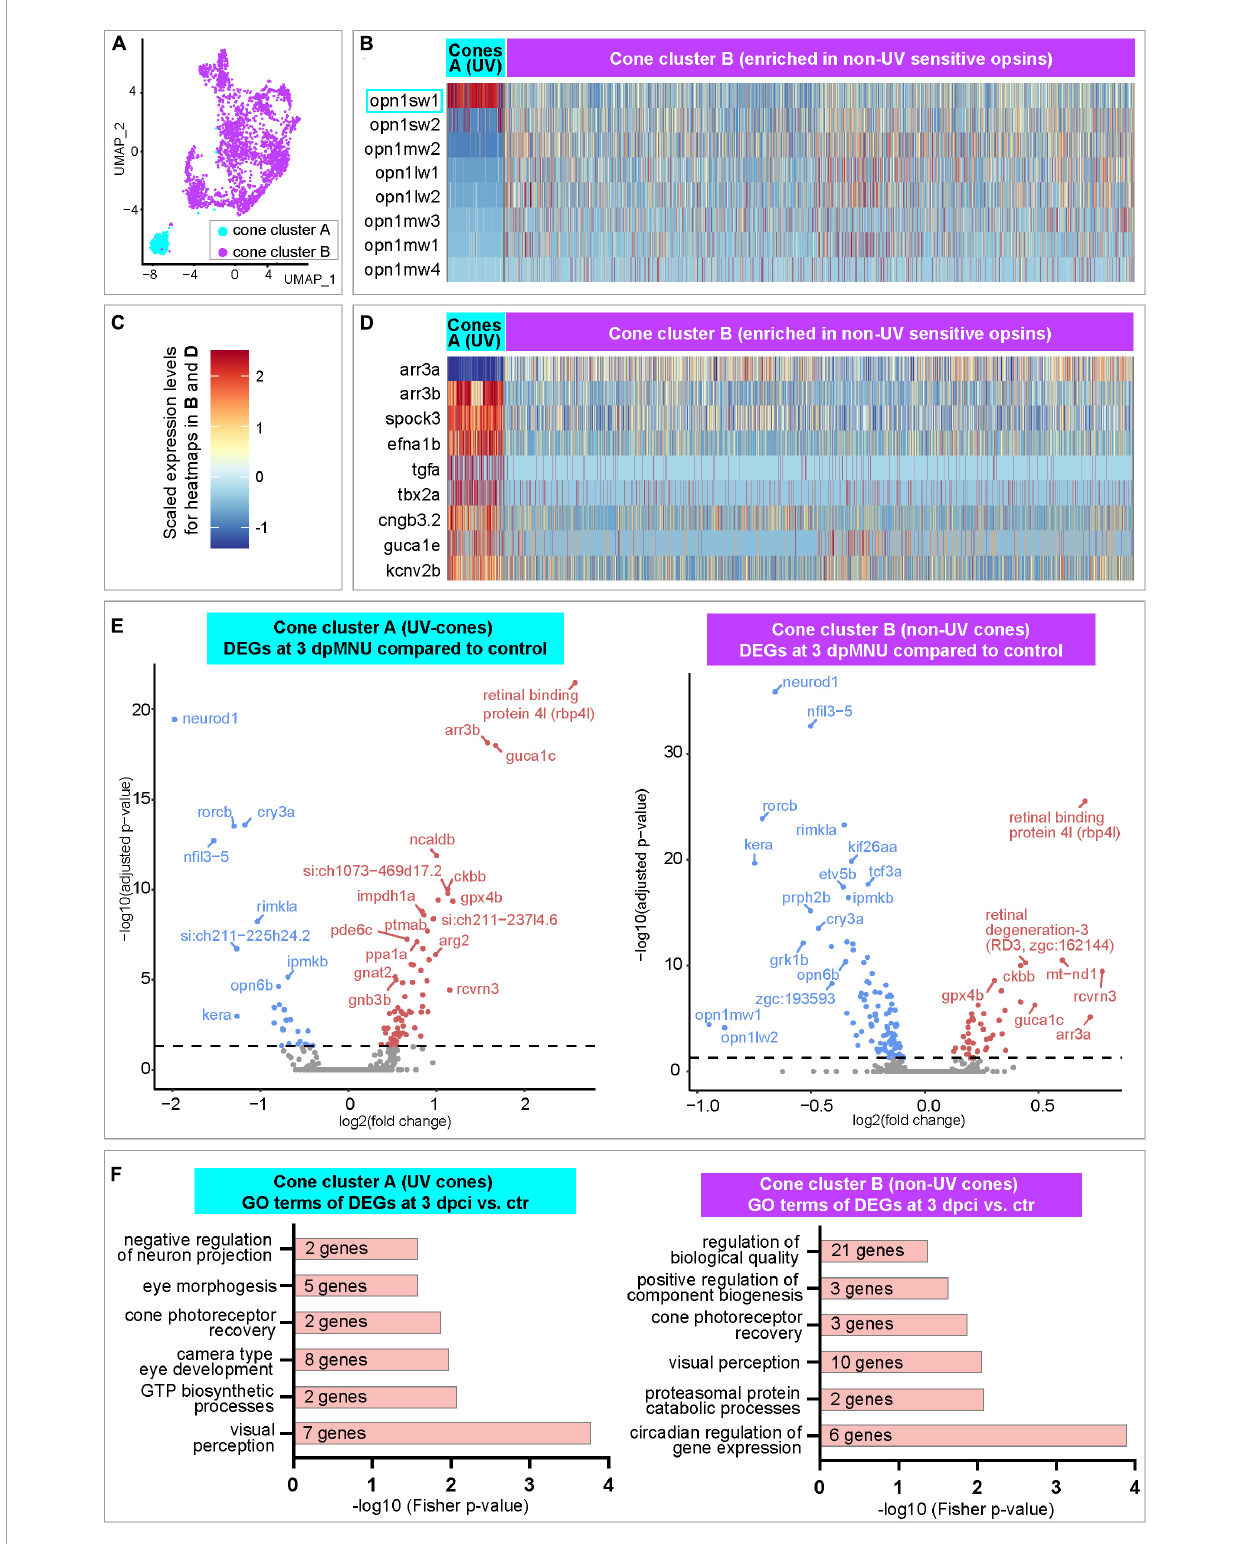
FIGURE7 Transcriptome dynamics of UV and non-UV cones following MNU chemical injury. (A) UMAP plot of merged datasets showing the cone clusters in color and other cell clusters in gray. (B) Heatmap of opsin-1 genes in cone clusters. Complete data are in Supplementary Table 7 . (C) A three-color scale used to indicate expression levels in heatmaps in panels (B,D) . (D) Heatmap of selected genes in cone clusters. Complete data are in Supplementary Table 7 . (E) Volcano plots of DEGs within each of cone clusters between 3 dpMNU compared to uninjured control. Complete data are in Supplementary Tables 8 , 9 . (F) Selected Gene Ontology terms of upregulated genes in each cone cluster. Complete data are in Supplementary Tables 8 , 9